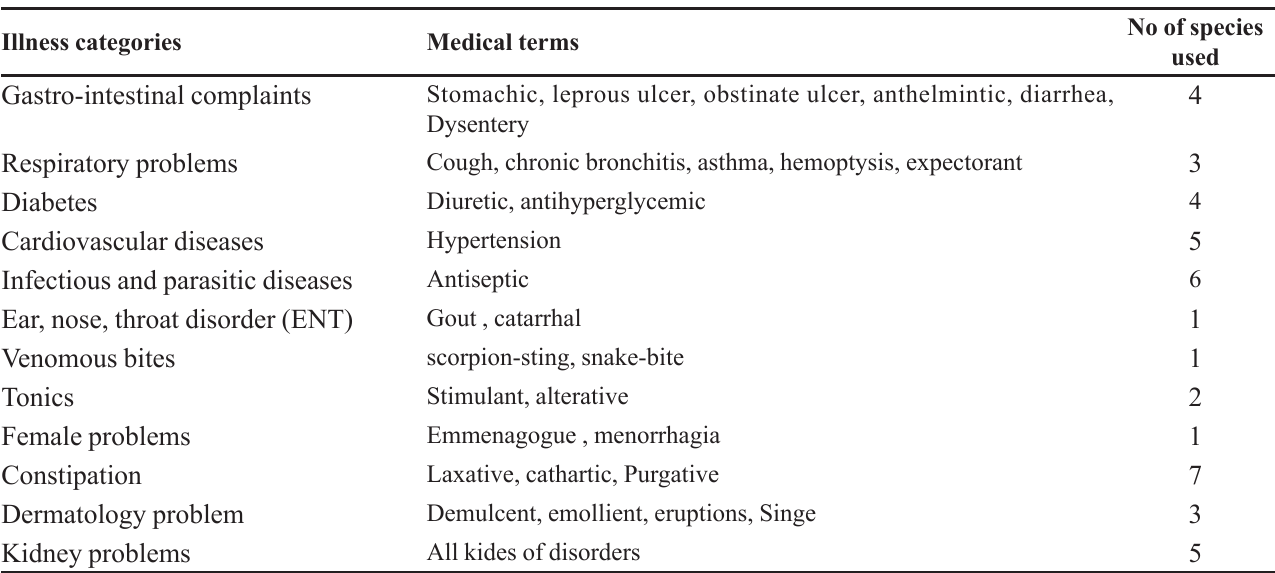
TABLE IV - Aliments grouped by different ailment categories (several diseases based on the similarity in one category)